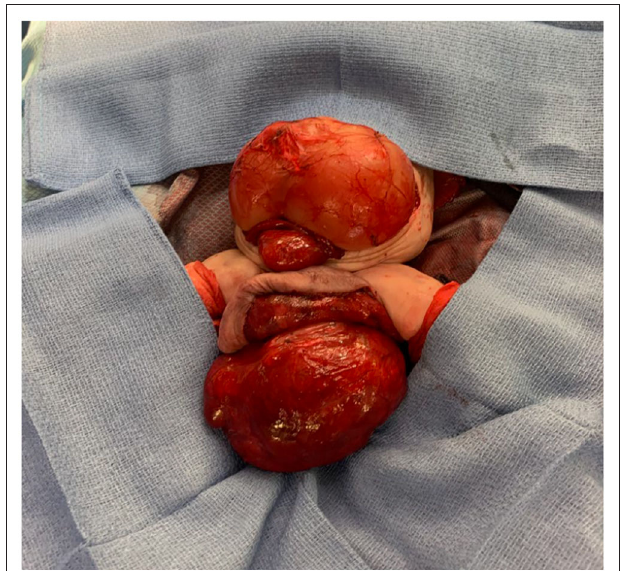
FIGURE 3 | Parasitic twin with both the abdominal and extracorporeal sacral component dissected and exposed.